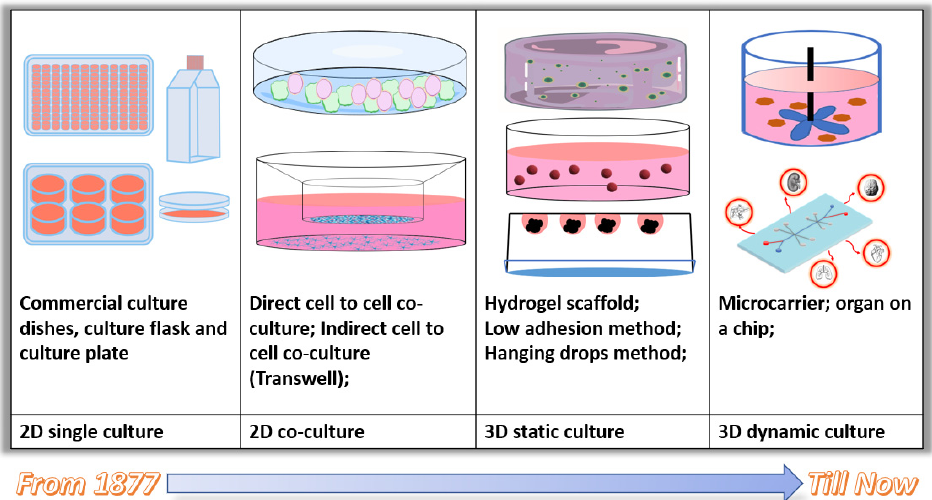
Figure 4. Evolution of the cell culture method.